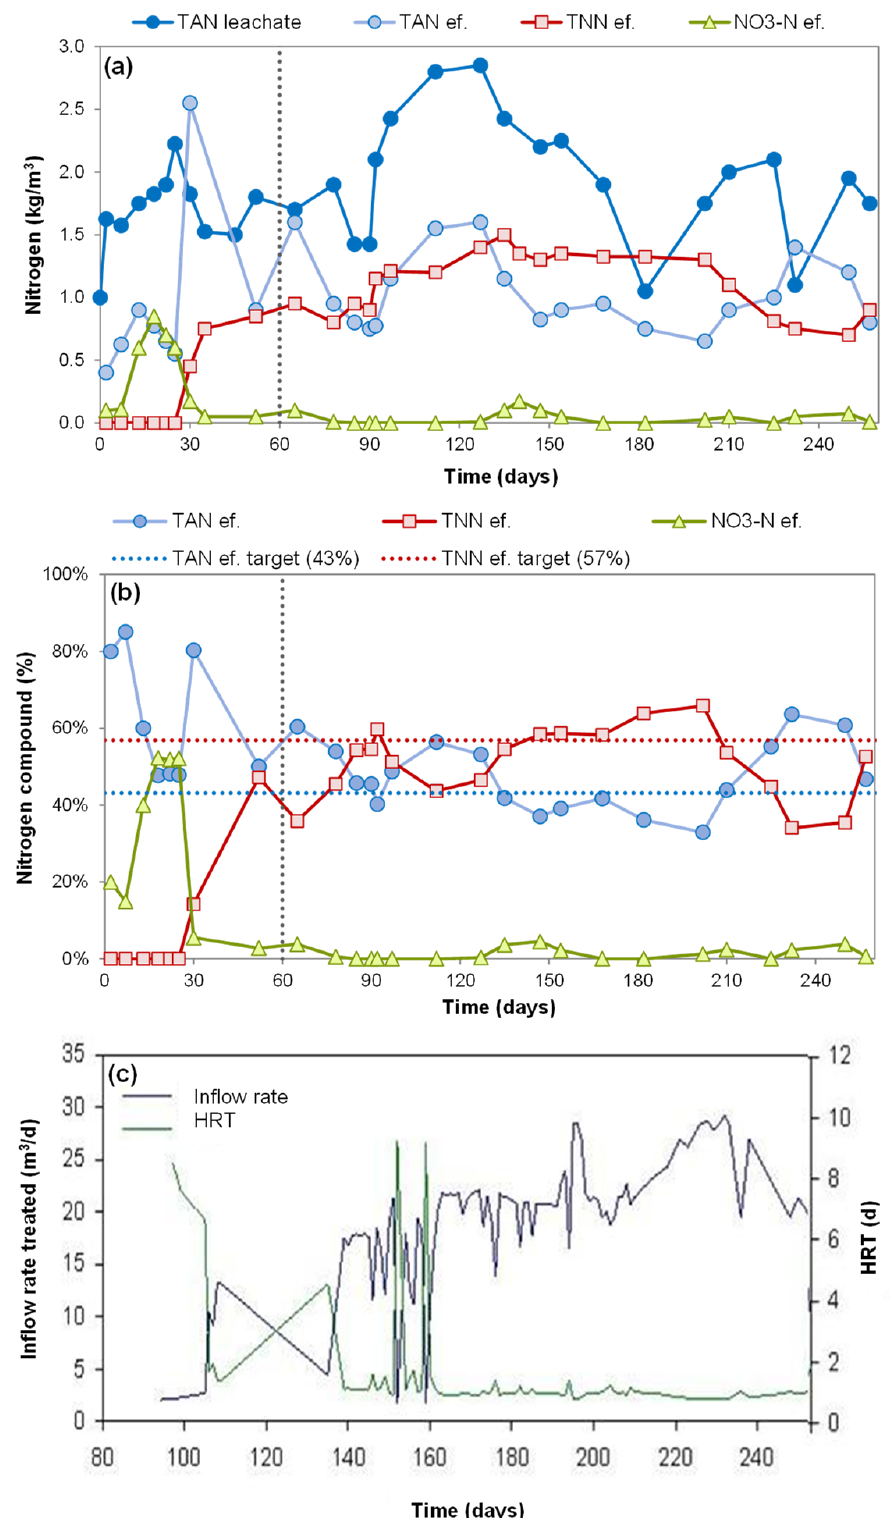
Figure 5. Performance of the full-scale PN-SBR during the start-up; ( a ) evolution of the concentration of the N compounds (TAN: total ammonium N, TNN: total nitrite N); ( b ) relative content of N compounds in the effluent; ( c ) inflow rate and hydraulic residence time (HRT)